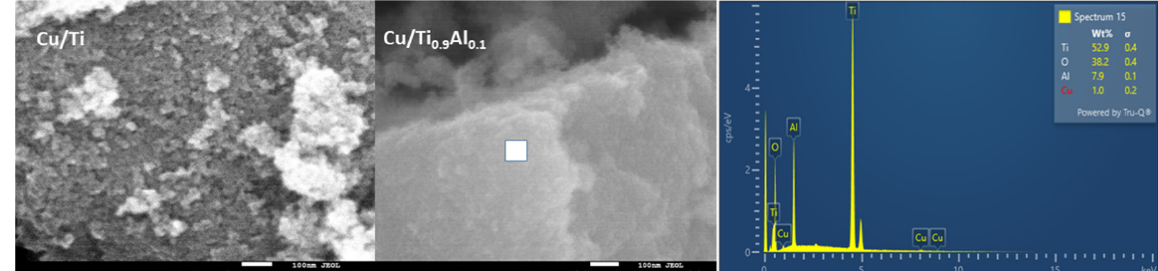
Figure 2. SEM images with the morphology of the Al-titania supported copper catalysts.